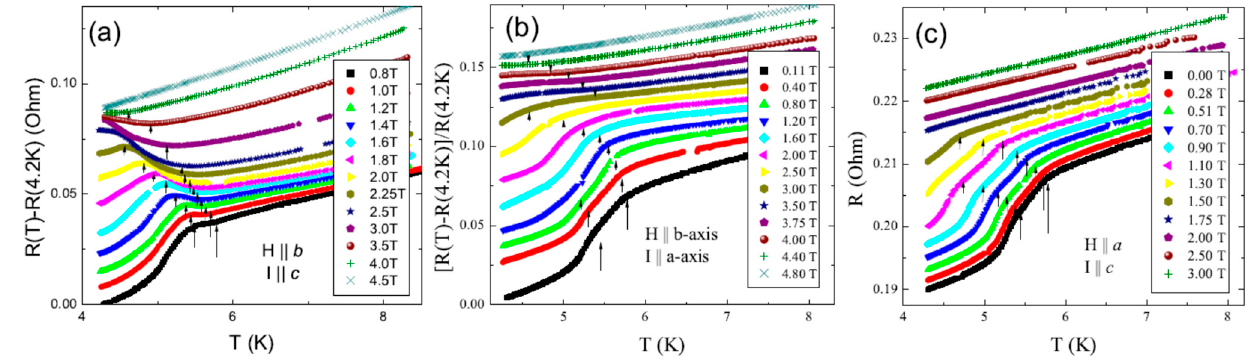
Figure 5. Temperature dependences of resistance R at various orientations of magnetic field with respect to crystal axes and electric current: ( a ) H || b and I || c ; ( b ) H || b and I || a . ( c ) H || a and I || c . The curves obtained at various fields are shifted for clarity.